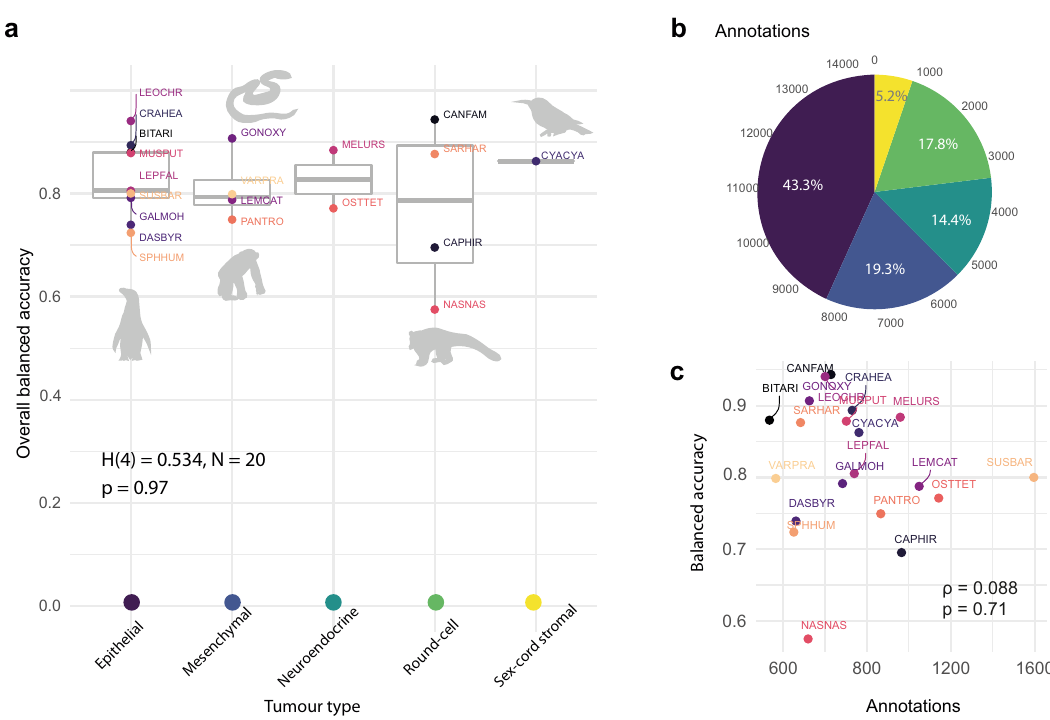
Fig. 2 | AI single-cell prediction comparison across tumour types. Balanced accuracy is computed as the average of sensitivity and speci fi city, ‘ overall ’ refers to the average of cancer, stromal and lymphocyte cells. a A Kruskal – Wallis test, n = 20, wasused to compare the overallbalanced accuracy between tumour types. Thick horizontal lines indicate the median value, out- liers are indicated by the extreme points, the fi rst and third quantiles are